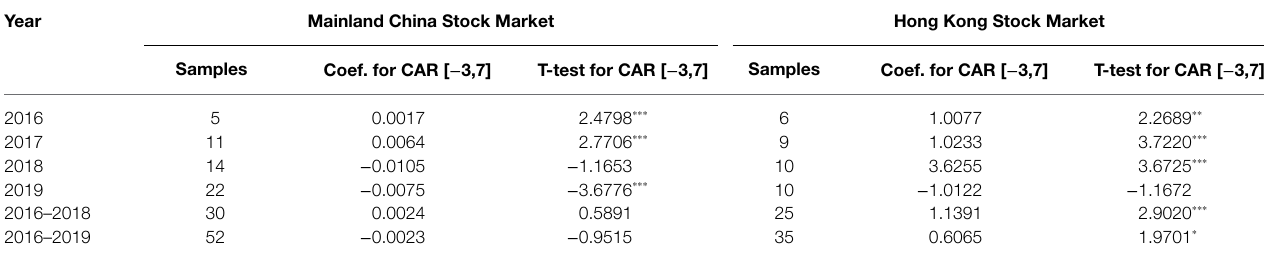
TABLE 5 | Robustness test results based on changing the estimation window.